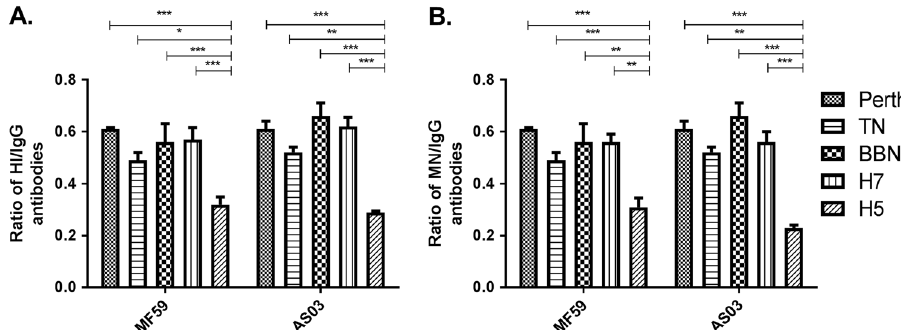
Fig. 6 Ratio of neutralizing antibodies as measured by a hemagglutination-inhibition (HAI) and b microneutralization (MN) assays per in fl uenza-speci fi c IgG titer. Proportion was determined based on area-under-the-curve (AUC) of the respective antibody titer induced over time, with the assumption of a linear antibody increase between the sampling periods. Statistical signi fi cance was determined by ANOVA, with Bonferroni ’ s correction applied for multiple pairwise comparisons. Asterisk denotes p -value < 0.05, ** p < 0.01, *** p <